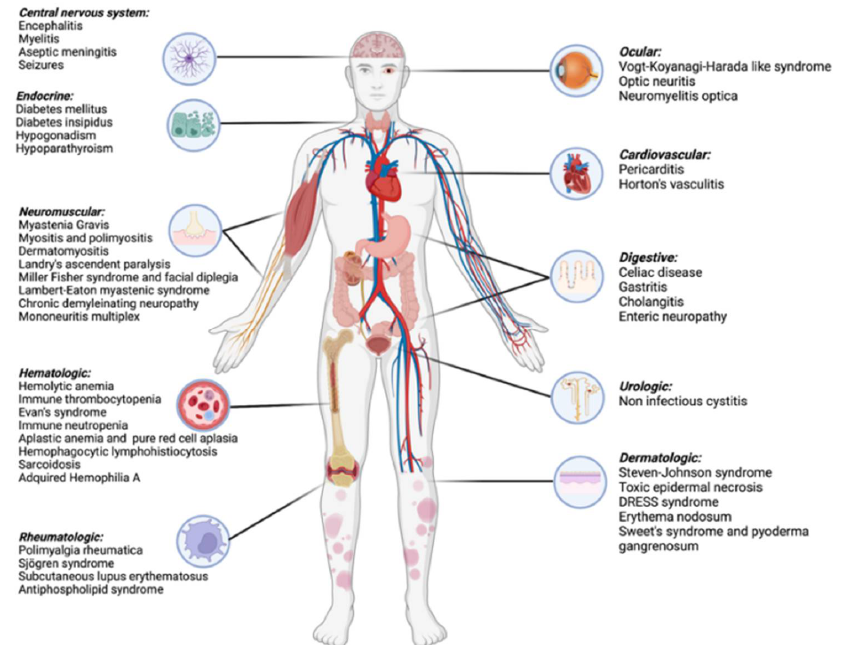
Figure 1. Uncommon irAEs are defined as those occurring at an incidence of less than 1%, whereas rare and very rare irAEs present at a frequency of less than 0.1 and 0.01% of cases, respectively. Other adverse reactions have a not-defined frequency, although its real incidence might be higher than previously published. Some anecdotical reports are also included here, given their rarity and, yet, interesting forms of